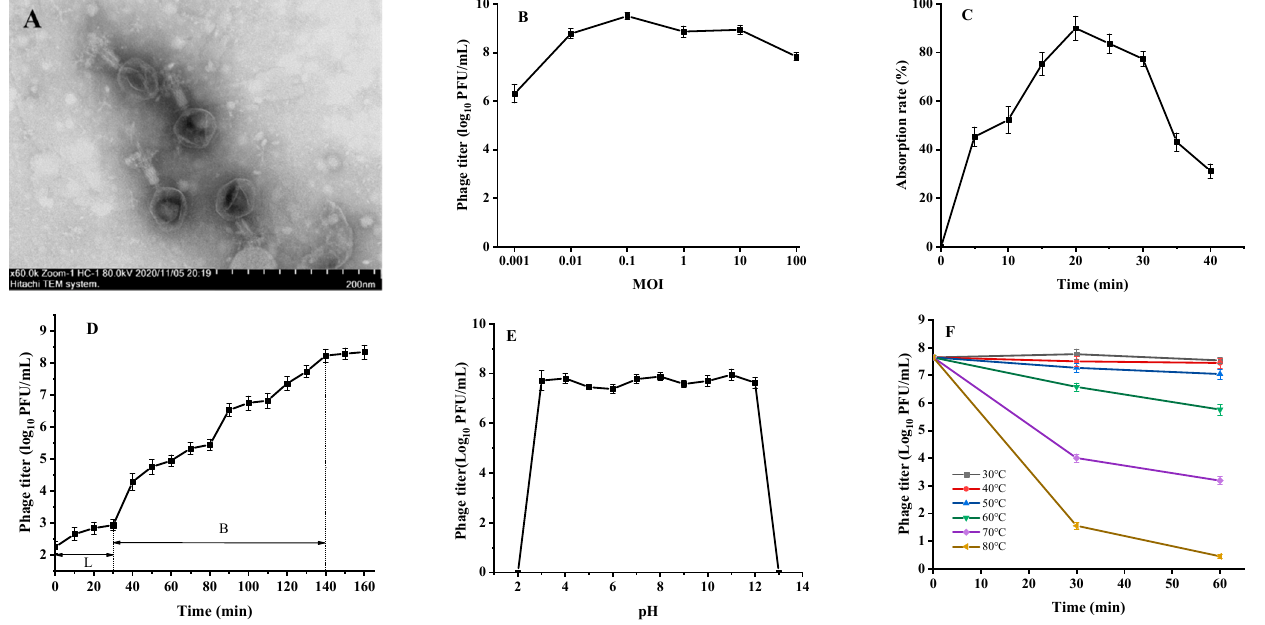
Figure 1. Biological characteristics of phage L66. ( A ) Representative TEM image of phage L66. ( B ) Inhibition curves of phage L66 on Salmonella of different MOI. ( C ) Adsorption assay of phage L66. ( D ) One-step growth curve of phage L66, “L”: Latent period, “B”: Breakout period. ( E ) Tolerance of phage L66 against different pH and ( F ) Thermal conditions.